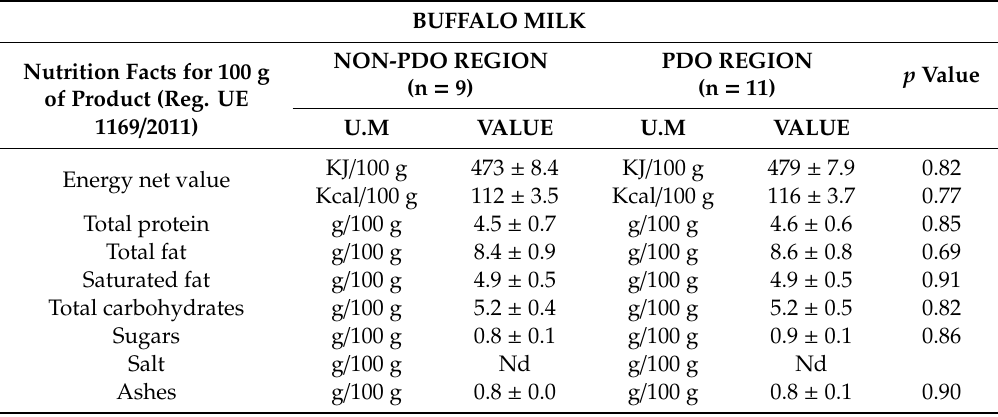
Table 1. Average composition of milk samples from di ff erent farms located in protected destination of origin (PDO) and non-PDO regions in Italy. Data are expressed as means ±